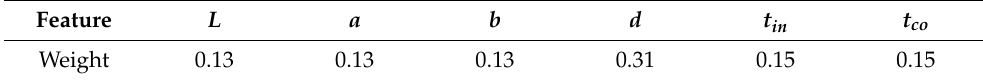
Table 1. Feature weights w f that determine feature importance in class similarity evaluations. Feature L a b d t in t co Weight 0.13 0.13 0.13 0.31 0.15 0.15